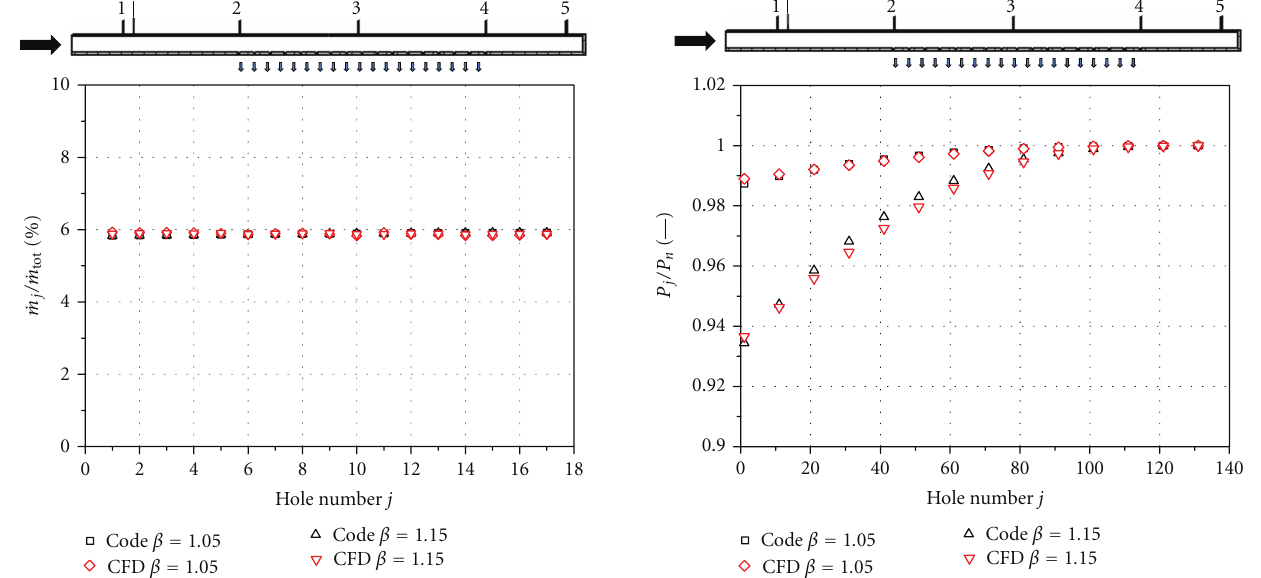
Figure 5: Mass flow split distribution for Geom 1 (percent).